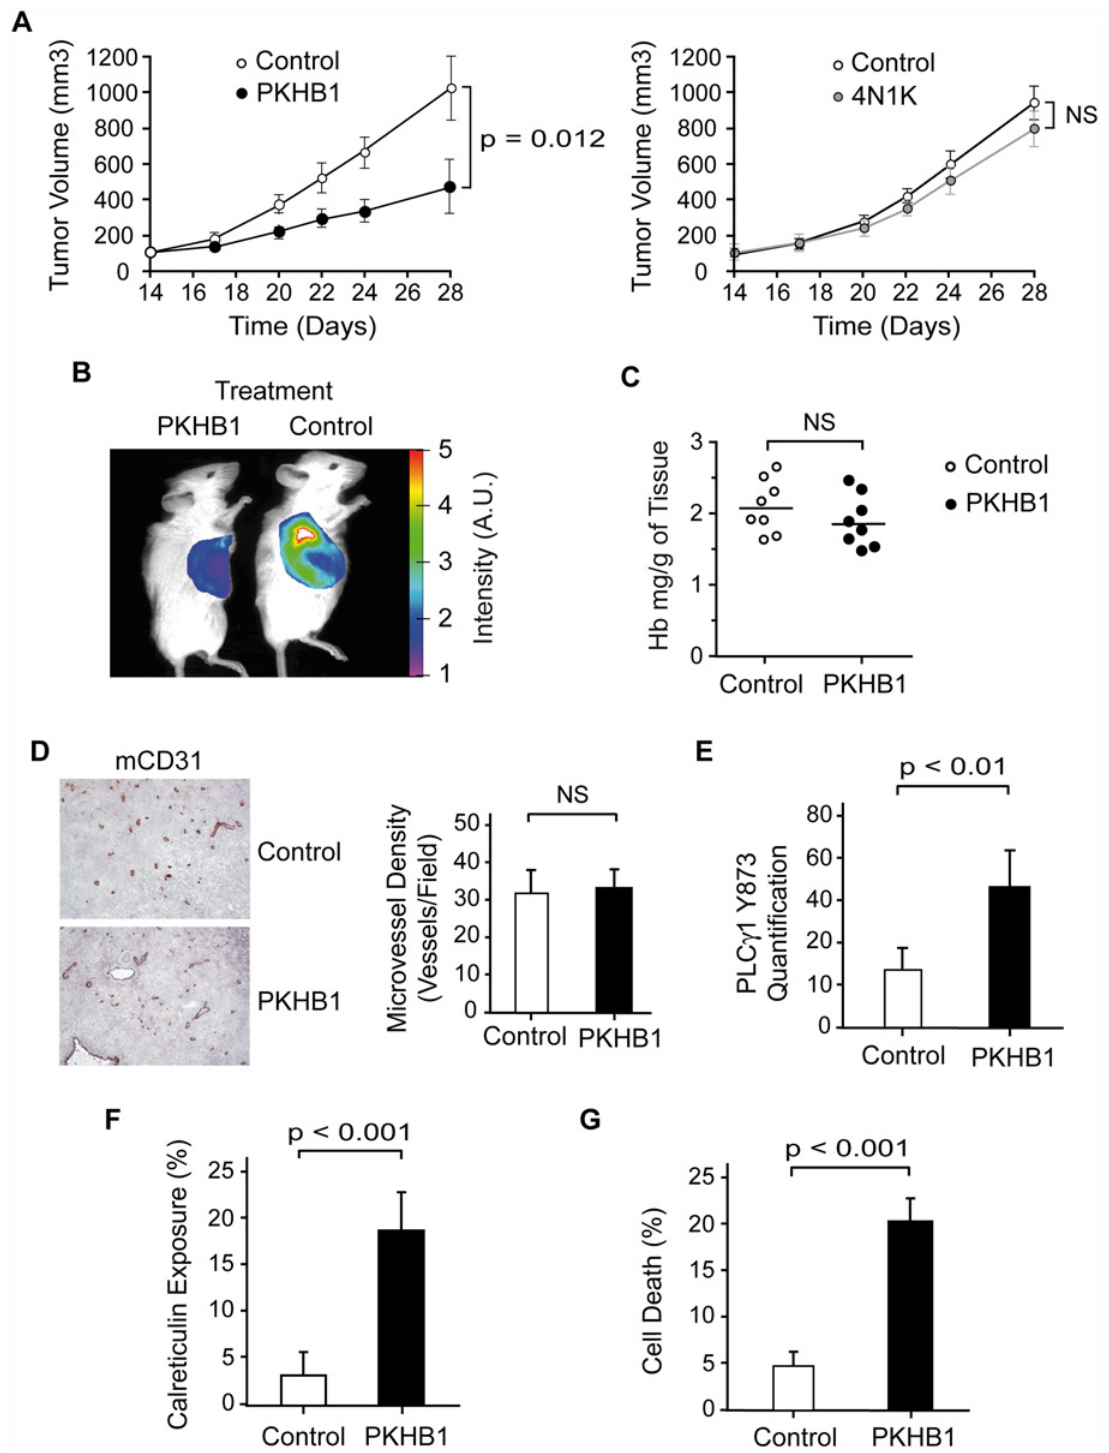
Fig 7. PKHB1 reduced in vivo CLL tumor burden by inducing PLC γ 1 activation and PCD. (A) NSG mice were subcutaneously transplanted with MEC-1 cells. Starting 14 d after the engraftment, the mice received a weekly intraperitoneal injection of vehicle (control), PKHB1 (left panel), or 4N1K (right panel). Tumor volume was measured using a caliper and graphed. The data are presented as mean ± SD ( n = 8). In contrast to vehicle or 4N1K treatment, PKHB1 treatment significantly reduced the tumor volume. (B) In an experiment similar to (A), tumor growth was visualized by measuring glucose uptake. The color scale indicates the fluorescence intensity. (C) The hemoglobin (Hb) concentration ( n = 8 per group) was assessed in vehicle- (control) or